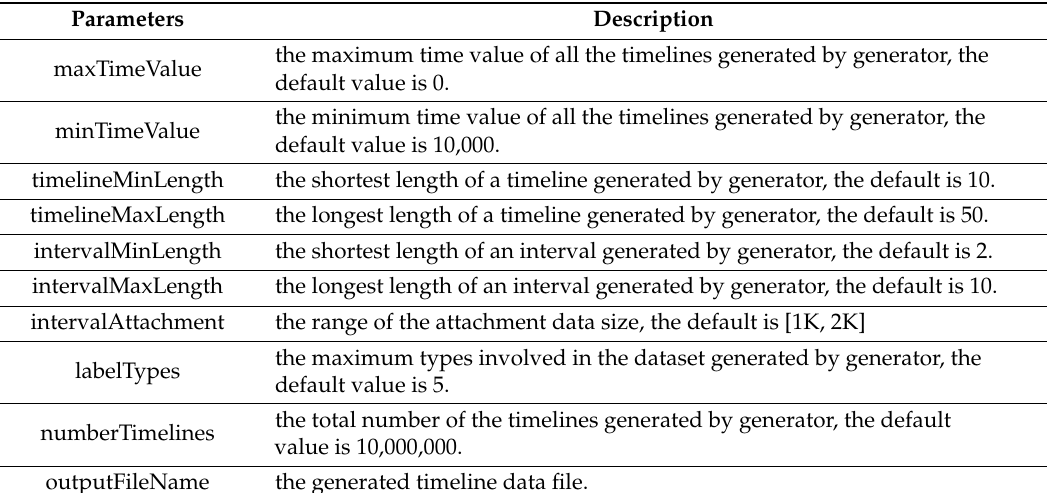
Table 4. Parameters of TimelineGenerator.